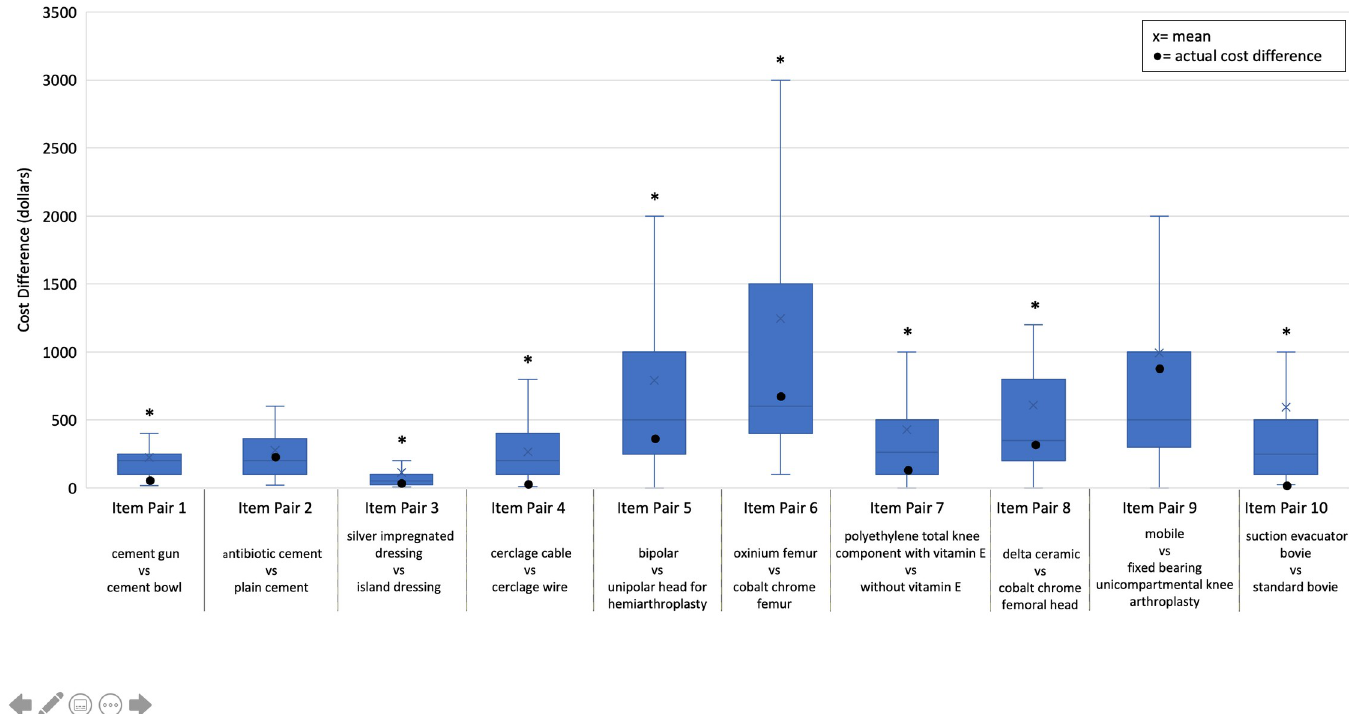
Fig 3. Perceived cost difference between paired items. Mean perceived cost differences between ten paired items for 102 respondents. x indicates the mean perceived cost difference, ● is the actual cost difference. T-tests used and significance (p < 0.05) is indicated by � .